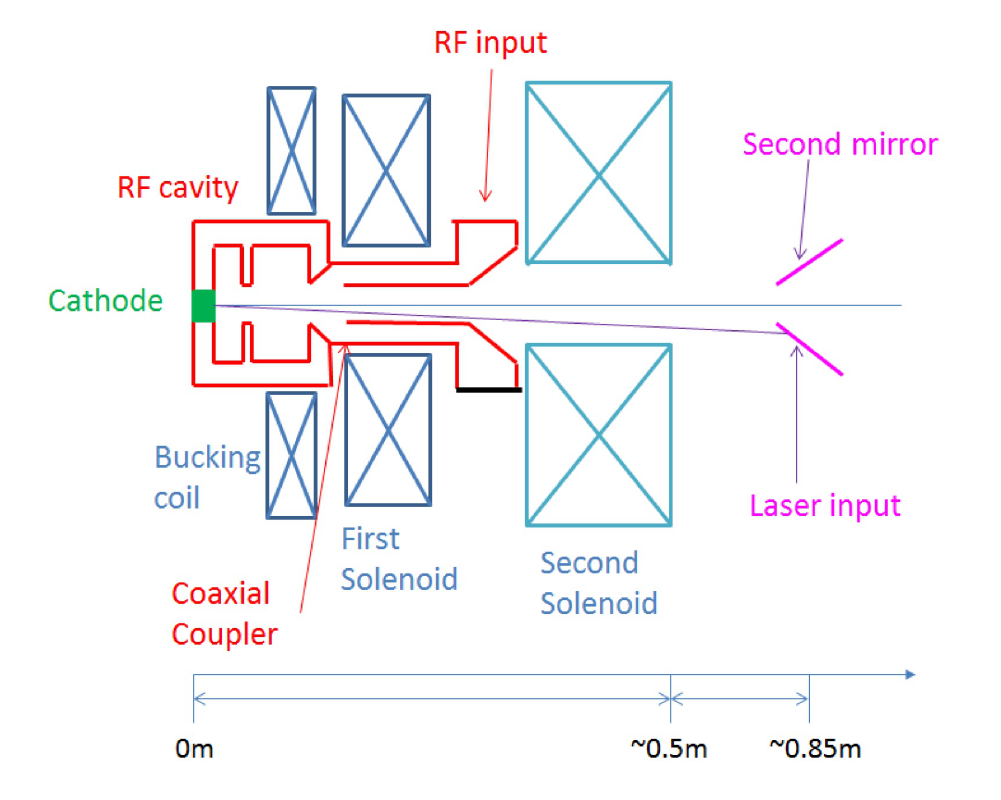
Figure 7. Sketch of the SINBAD-ARES